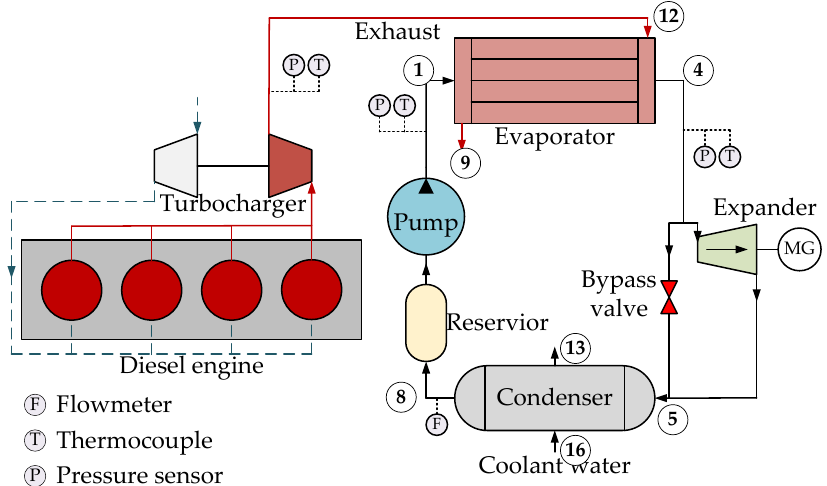
Figure 2. The conceptual schematic of the engine–ORC system.